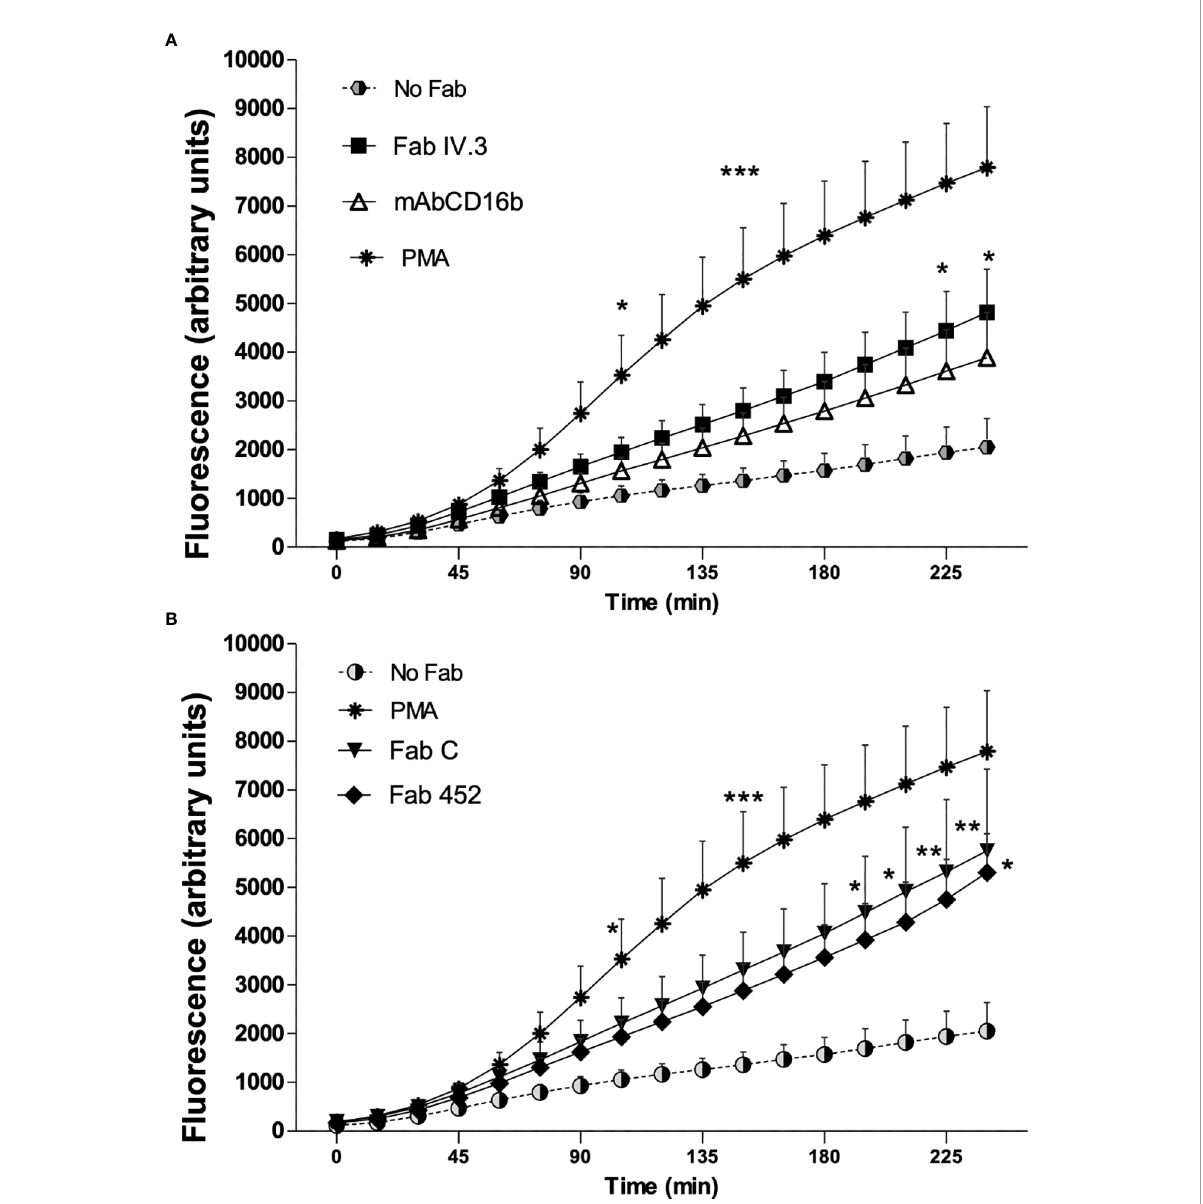
FIGURE 4 Production of reactive oxygen species associated to phagocytosis mediated by CD13 and Fc g R in neutrophils. Human neutrophils were preincubated on ice with Fab fragments of anti-Fc g RII (Fab VI.3) or Fab fragments of anti-CD13 (Fab 452 or Fab C) or mAb anti Fc g RIIIb (CD16b) or no treatment (No Fab). The cells were washed and loaded with carboxy-H2DFFDA, for 30 min at 37°C. After washing, the cells were mixed with EBS-Fab not labeled with CFSE at a ratio of 20 EBS-Fab to 1 cell, in wells of black 96-well Inmuno Plates, and the fl uorescence from oxidized carboxy-H2DFFDA was determined immediately and every 15 min as described in Materials and Methods. Results are expressed as mean ± SEM of 7 independent experiments, except for Fab 452 where n=5. Stimulation with PMA was used as a positive control. Statistical signi fi cance was computed through a one-way ANOVA with a Tukey post hoc test. *p<0.05, **p<0.01, ***p<0.001. A and B graphs display data from the same experiments, but are shown separately for